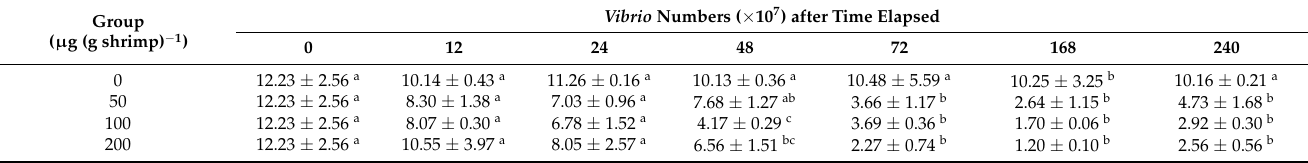
Table 1. Vibrio numbers of Litopenaeus vannamei that received the water extract of Panax notoginseng at 50, 100, and 200 µ g (g shrimp) − 1 and control